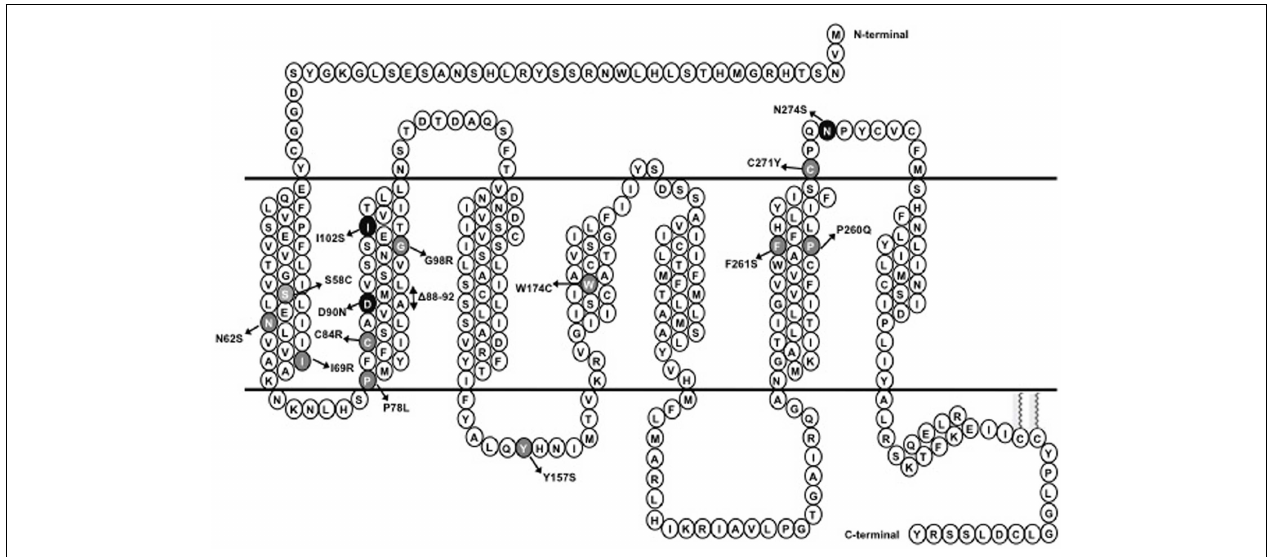
FIGURE 1 | Schematic representation of MC4R . Naturally occurring mutations of the MC4R characterized in this study are highlighted; mutations that result in intracellular retention of the MC4R are highlighted in gray whereas mutations that do not interfere with the cell surface expression of the MC4R are highlighted in